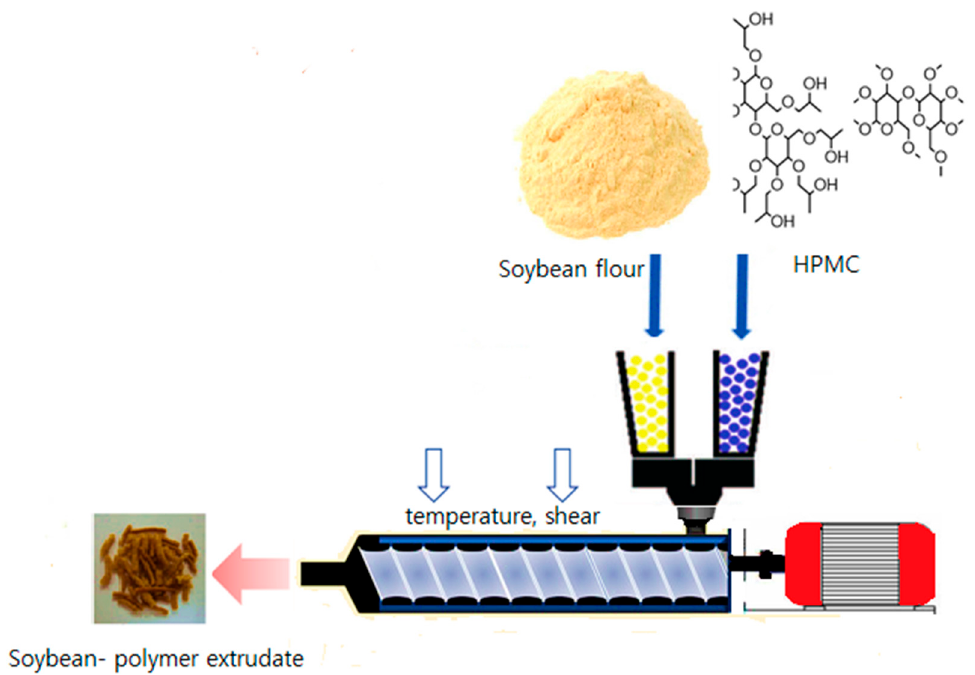
Figure 1. Schematic diagram of the preparation of the soybean-polymer food composite. HPMC: hydroxypropyl methylcellulose.